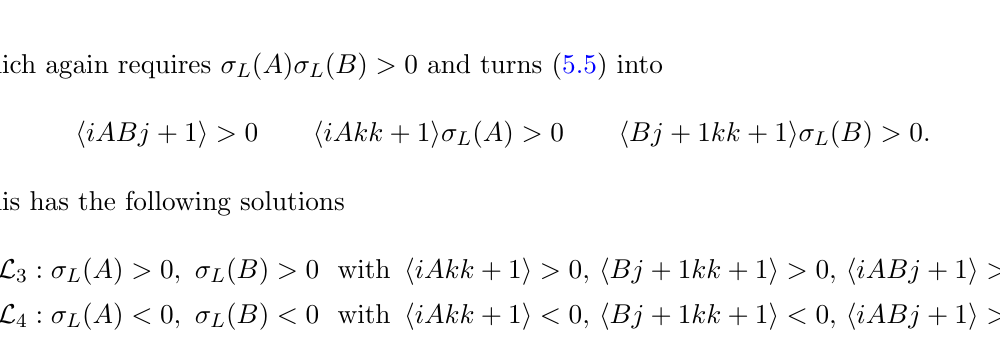
Table 1 . Parametrization of ( AB ) in the four